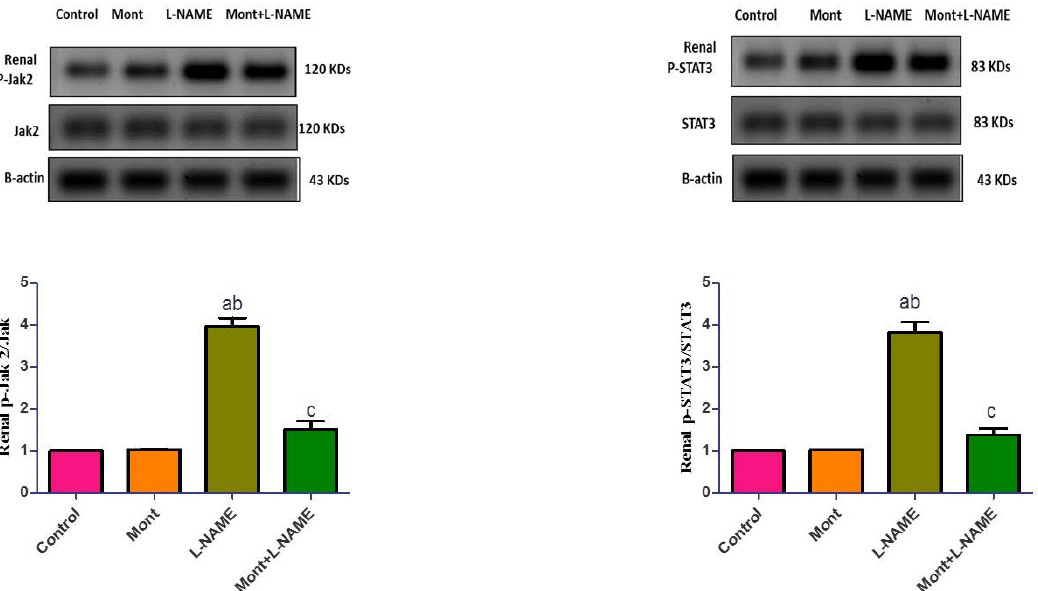
Figure 5. Effect of montelukast on renal p-Jak2 and p-STAT3 in a pre-eclampsia model in rats. The results show the mean ± SEM (8 rats/group). (a) Significant ( p < 0.05) difference from the control group. (b) Significant ( p < 0.05) difference from the Mont group. (c) Significant ( p < 0.05) difference from the L-NAME group. [Mont: montelukast; L-NAME: L-NG-Nitro arginine methyl ester; Jak2: Janus kinase 2; STAT3: signal transducer and activator of transcription 3].